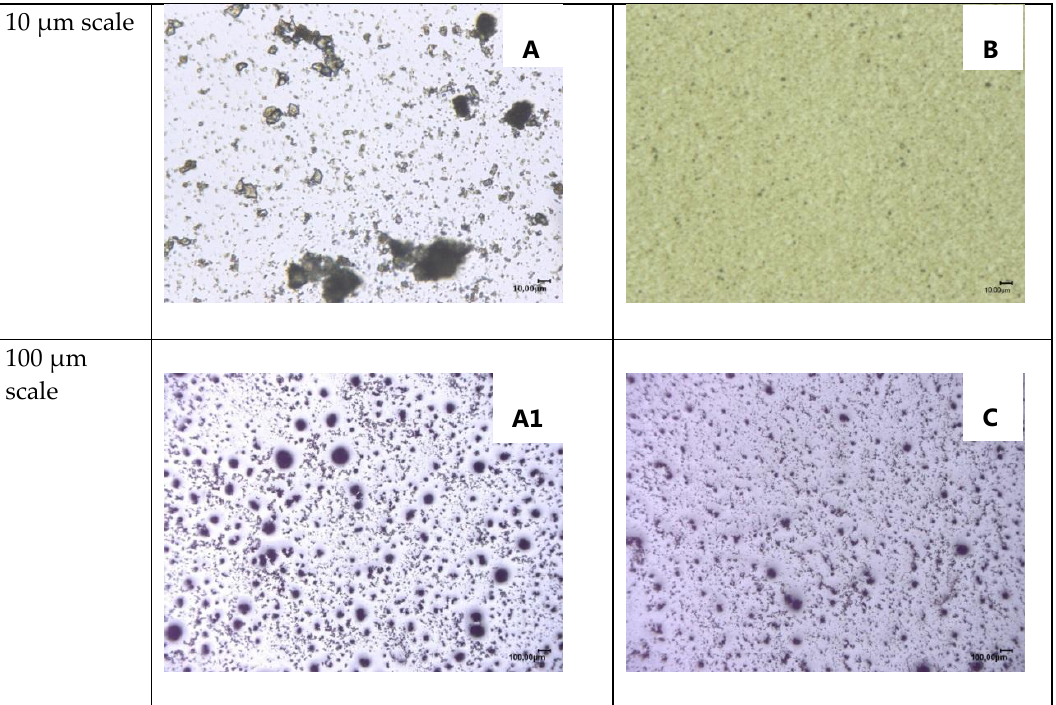
Figure 4. Optical images of EDA-DOPO dispersions in the polyol: ( A , A1 ) 5% EDA-DOPO dispersed in polyol using high speed homogenizer, ( B ) 5% EDA-DOPO dispersed in the polyol using a planetary ball mill, ( C ) 5% EDA-DOPO dispersed using sodium dodecyl sulfonate in polyol using high-speed homogenizer.